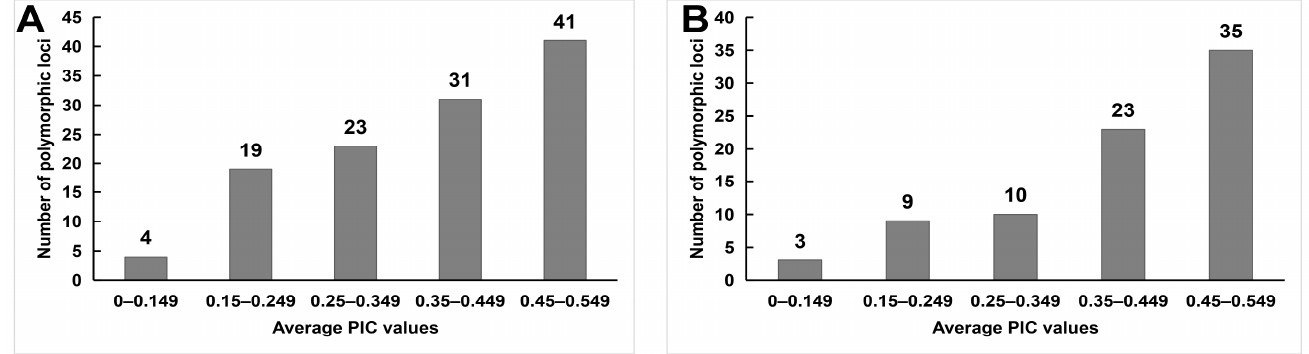
Figure 3. The relationship between the frequency of polymorphic loci and the total PIC value, which was ampli fi ed by IRAP ( A ) and ISSR ( B ) markers in 46 rhododendron accessions. Table 1. Information content of IRAP and ISSR markers and other polymorphism indices from 46 wild rhododendron accessions.